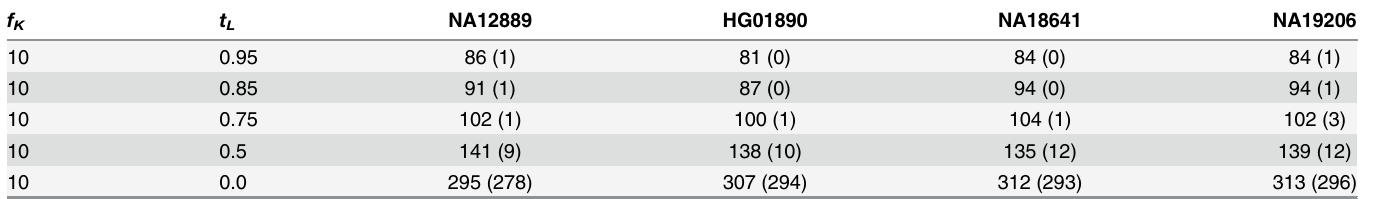
Fig 5. Assembled repeats matching AluYd3 (a Repbase repeat) by REPdenovo (bottom panel) and RepARK (top panel). The matched assembled repeats are shown on their mapped positions where the AluYd3 consensus repeat sequence serves as the reference. doi:10.1371/journal.pone.0150719.g005 Table 8 shows the repeat assembly performance on all four individuals (including NA12889). We can see that results from REPdenovo overall keep consistent as the matching cutoff t L changes from 0.0 to close to 1.0 (by default, t L is chosen to be 0.85). Also, REPdenovo outperforms RepARK in terms of the completeness and the number of long repeats con- structed. This is benefit from the assembling raw contigs and filtering steps. As copies of a repeat are diverged from each other, lots of short pieces (of copies) will be assembled because of the variations on the copies, and assembling these raw contigs will help to construct the complete repeats, while RepARK only reports these pieces. Thus, REPdenovo works better for constructing more diverged repeats. However, it is still possible for REPdenovo to wrongly assemble contigs, even though there is a filtering step. Table 8. The number of repeats in Repbase that match (over the minimum threshold t L ) one de novo repeat. The numbers outside and side the paren- theses are REPdenovo and RepARK results, respectively. t L : matching